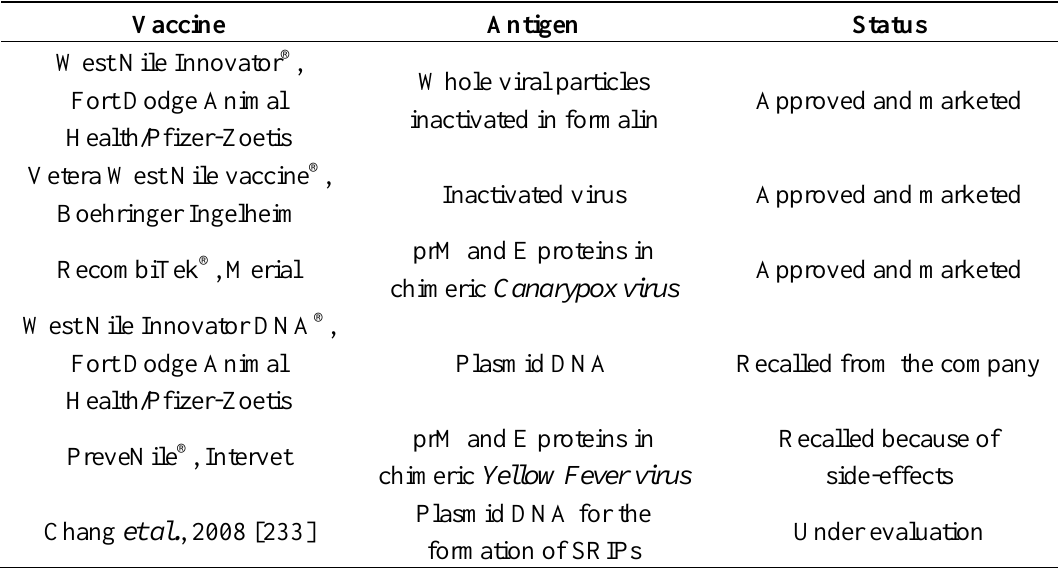
Table 8. Vaccines against WNV for